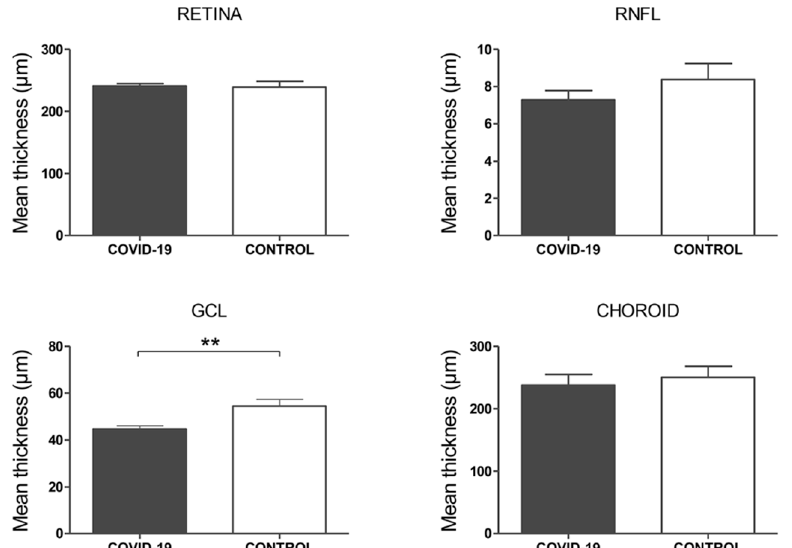
Figure 3. Structural optical coherence tomography (OCT) analysis, macula. Mean foveal thickness (central subfield of the ETDRS grid) in microns of the retina, retinal nerve fiber layer (RNFL), ganglion cell layer (GCL), and choroid layers. p -values correspond to a comparison between COVID-19 patients and controls. Error bars correspond to the SEM. ** p < 0.01.